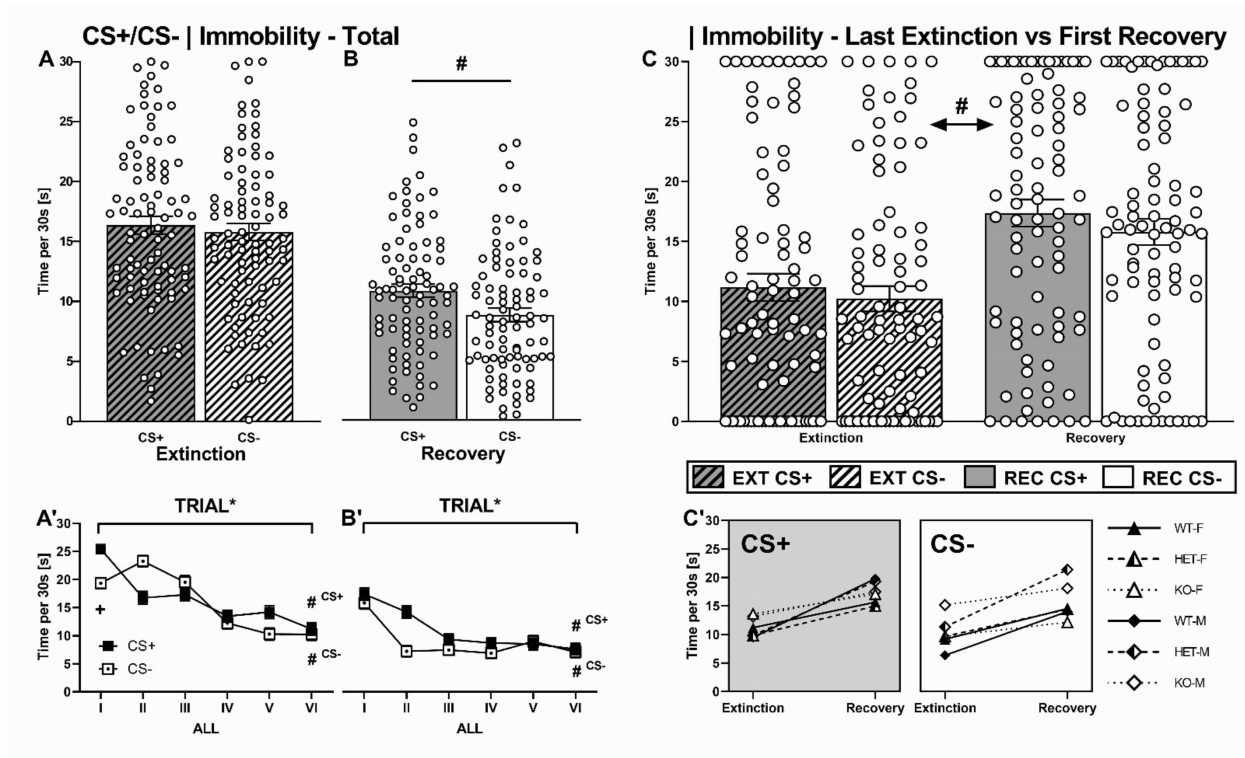
Figure 5. CS+/CS- presentation: immobility across all rats. Effects of SERT deficiency on immobility for CS+ and CS- presentations during extinction ( A , A’ ) and recovery ( B , B’ ), as well as the comparison of last trial extinction vs. first trial recovery ( C–C’ ). Depicted are the total amounts of immobility for CS+ presentations (grey striped bar) and CS- presentations (white striped bar) during extinction ( A,C ), as well as CS+ presentation (grey bar) and CS- presentation (white bar) of recovery ( B , C ). Furthermore, single trial immobility levels for extinction ( A’ ) and recovery ( B’ ) are shown by means of CS+ presentations (black squares) and CS- presentations (white squares with dot). N = 87 rats. Data are presented as mean ± SEM. TRIAL* p < 0.05 effect of time course. # p < 0.05 significant within-subject comparison of various CS presentations. + p < 0.05 for within-subject comparison of first CS+ and CS- presentation. #CS+ p < 0.05 for within-subject comparison of first and last CS+ presentation. #CS- p < 0.05 for within-subject comparison of first and last CS-